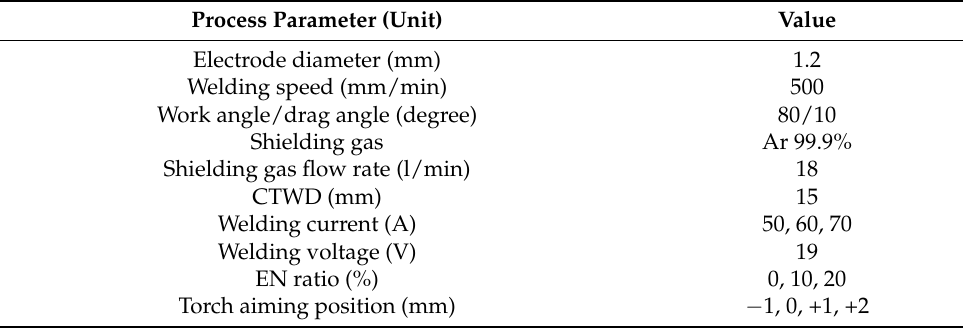
Table 3. Welding parameters used for